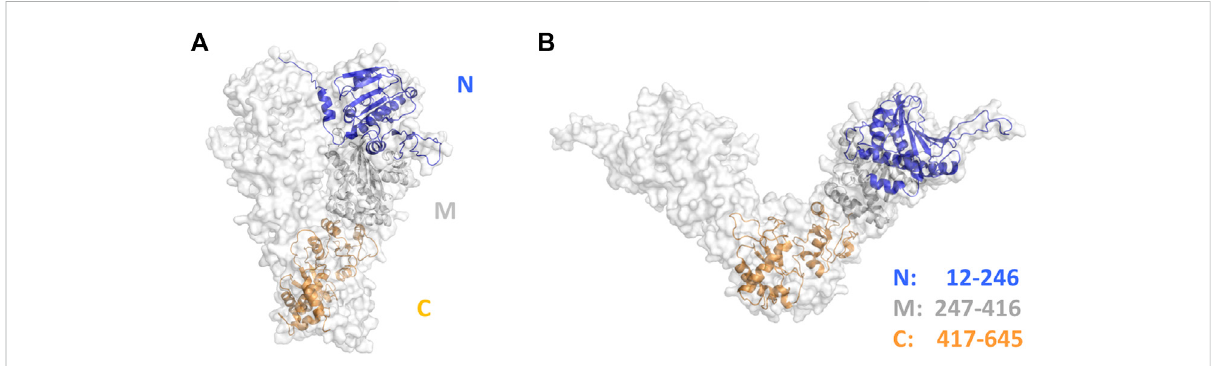
FIGURE 1 Cartoon and surface representations of (A) the AlphaFold2.0 structure of HtpG Mtb and (B) its homology model in the ligand-free state. Structure-based domain boundaries of the catalytic N-terminal (N, blue), middle (M, grey) and C-terminal (C, orange) domains are reported with the same colour